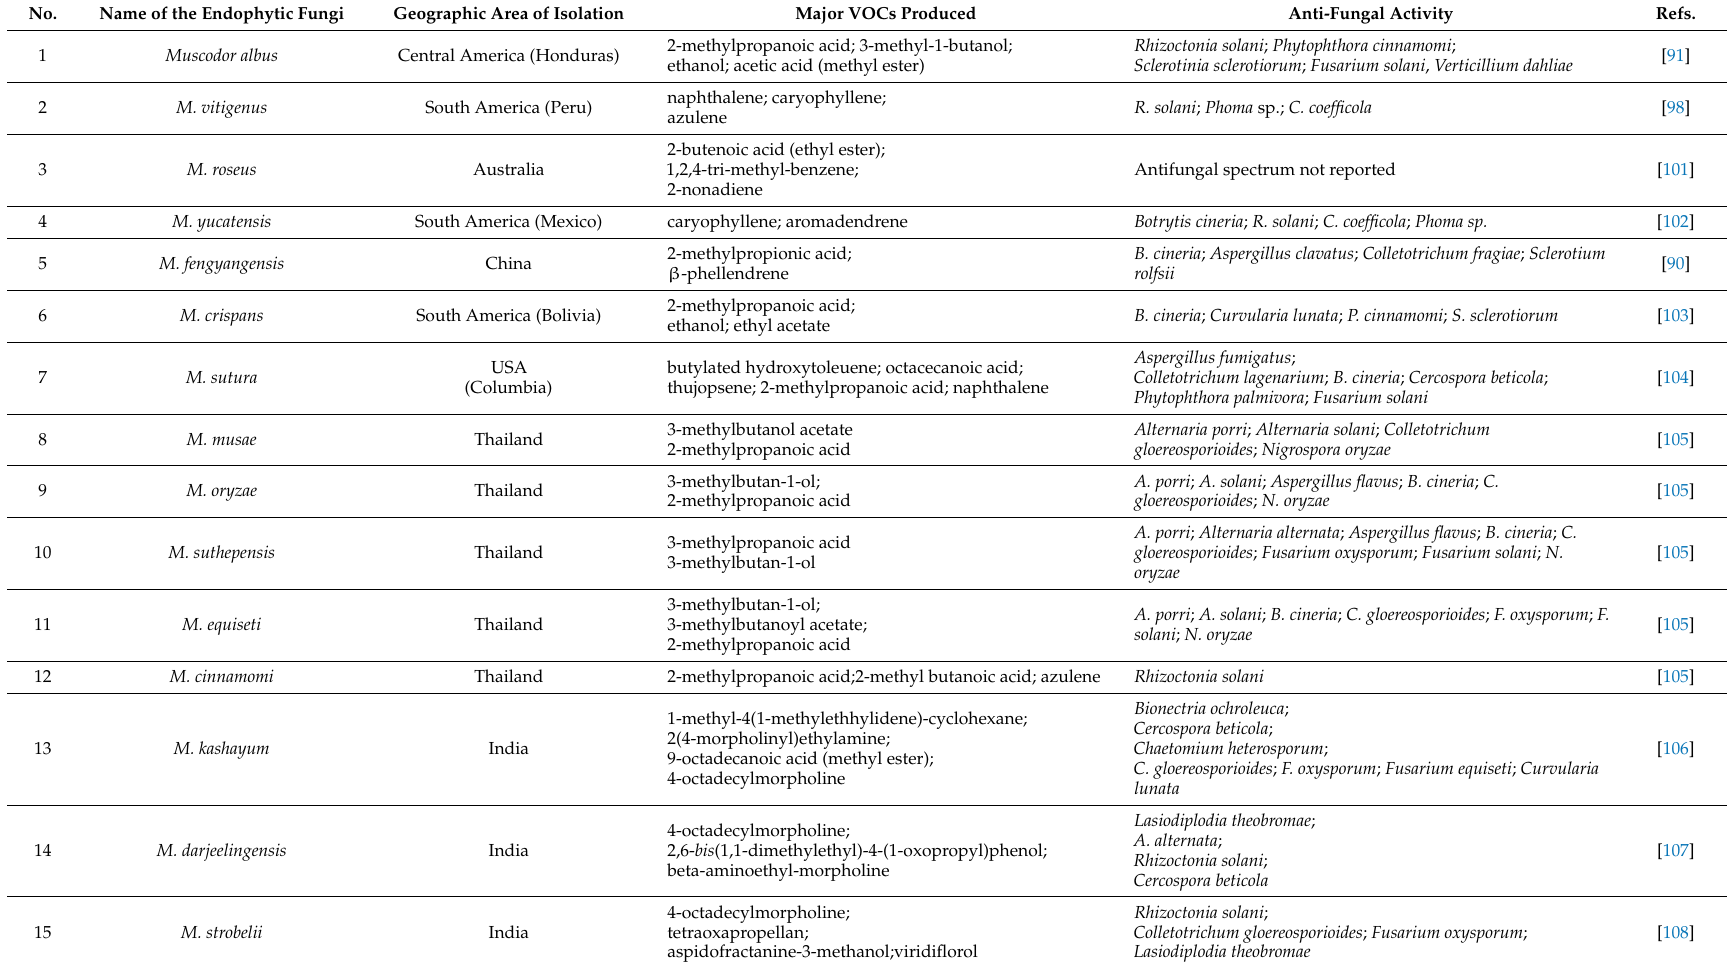
Table 2. Spectrum of VOCs emitted by Muscodor species and their anti-fungal activity predominantly against plant pathogenic